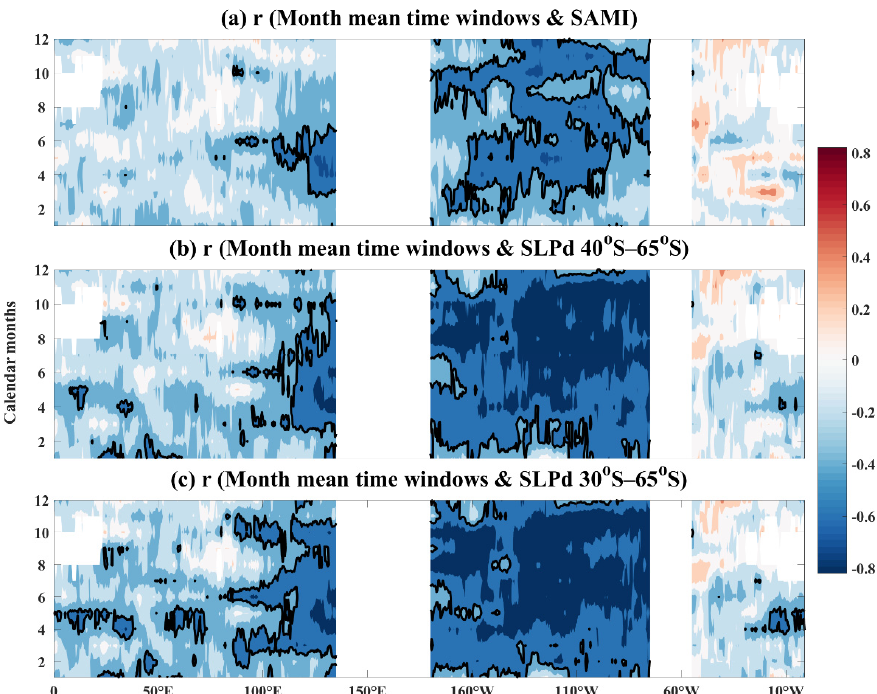
Figure 8. Correlation between the number of time windows for crossing the westerlies and (a) the SAMI, (b) the sea-level pressure differences between 40° S and 65° S, and (c) the sea-level pressure SAMI, ( b ) the sea-level pressure differences between 40 ◦ S and 65 ◦ S, and ( c ) the sea-level pressure differences between 30° S and 65° S. The black contours indicate the 0.4 isoline indicating statistical differences between 30 ◦ S and 65 ◦ S. The black contours indicate the 0.4 isoline indicating statistical significance at the 95% level. significance at the 95%